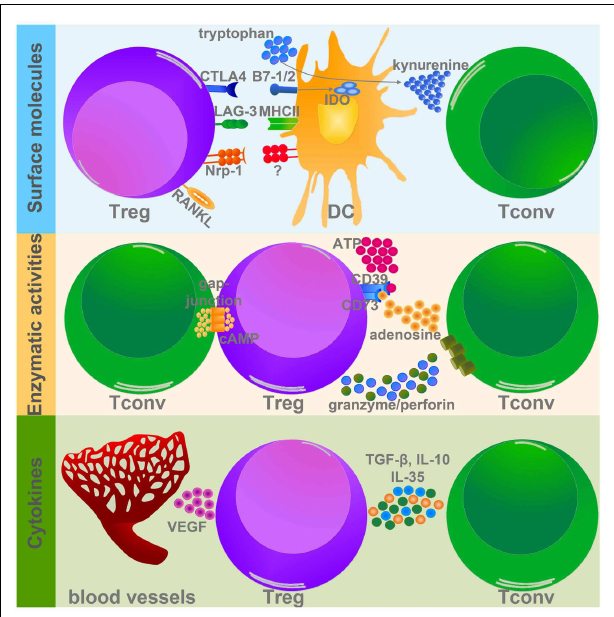
FIGURE 1 |T reg suppressive mechanisms in tumor microenvironment .